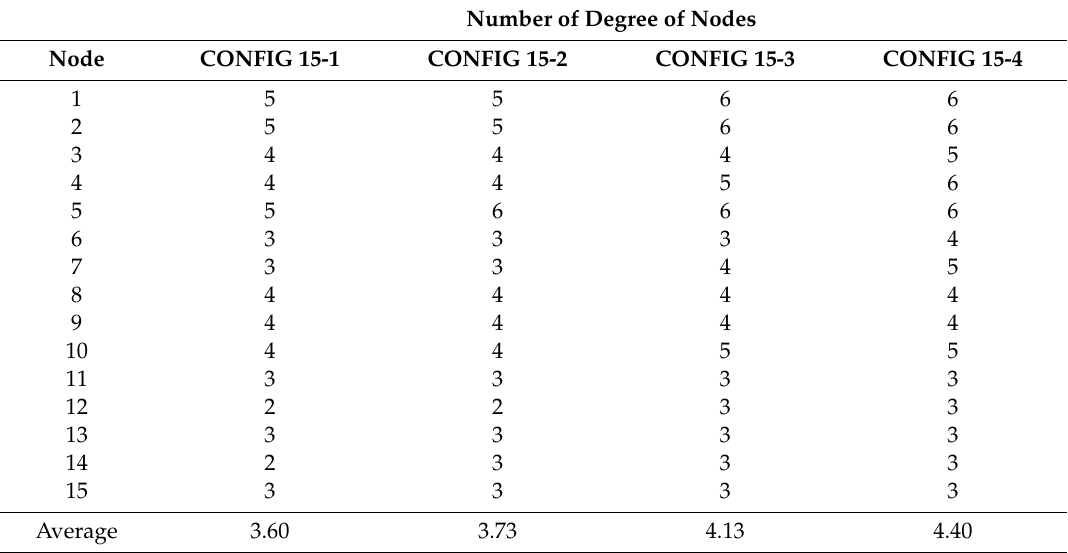
Table 4. Simulation results for 15 nodes. Number of Degree of